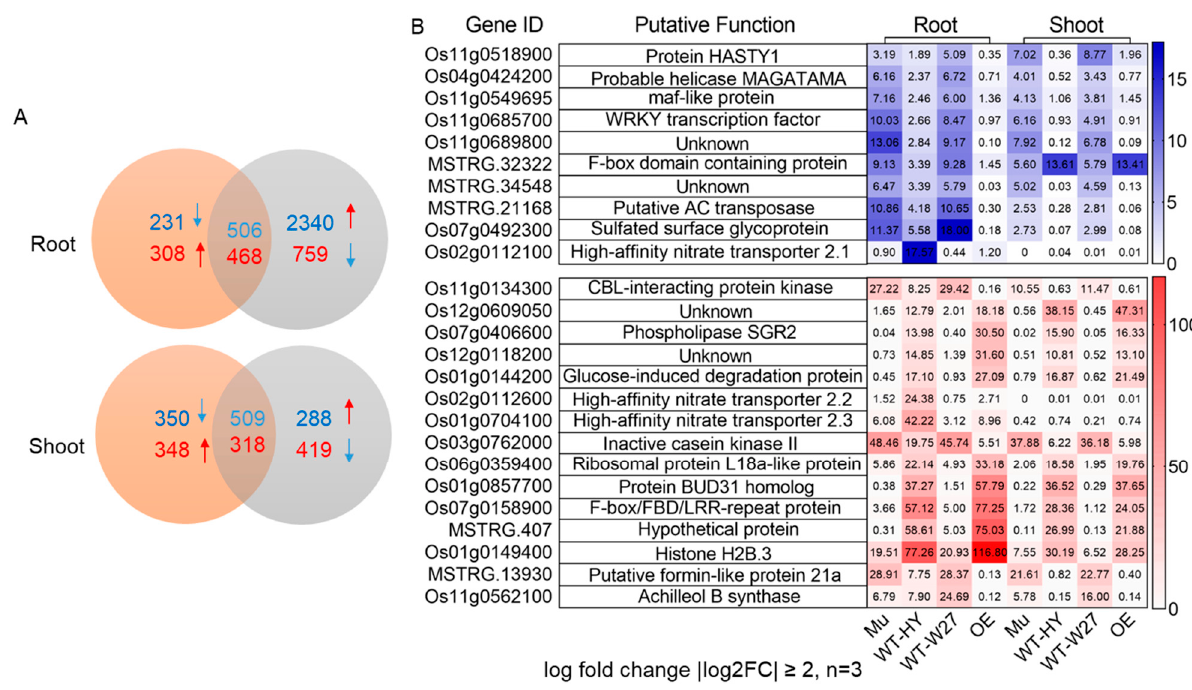
Figure 2. RNA-seq analysis of OsTBP2.1 overexpression lines and T-DNA insertion mutant lines. ( A ) The number of different expression genes (DEGs) identified by the RNA-seq dataset in the roots and shoots of OE and ostbp2.1 . The samples taken from the shoots and roots of OsTBP2.1 overexpression lines (OE) and T-DNA insertion mutant lines ( ostbp2.1 ). Blue arrow, downregulated genes in OE and ostbp2.1 . Red arrow, upregulated genes in OE and ostbp2.1 . ( B ) Individual accession number, putative function, and relative expression of the 25 genes selected from ( A ). Log fold change |log 2 FC| ≥ 2 of the RNA-seq analysis (n = 3).